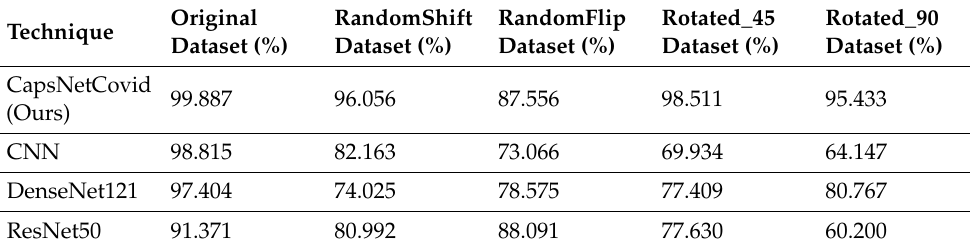
Table 8. Sensitivity of CapsNetCovid, CNN, DenseNet121, and ResNet50. Technique